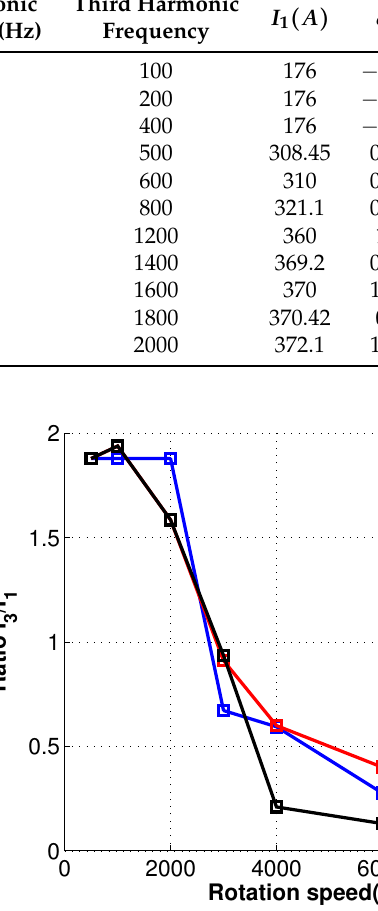
Figure 6. Variation of ratio I 3 / I 1 for the three control